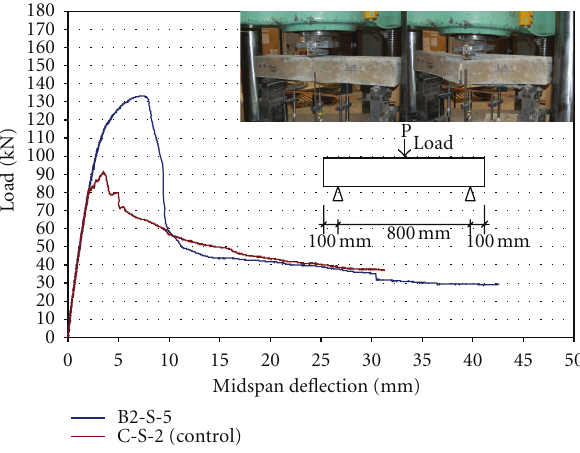
Figure 15 for comparison. Test results of beams B2-S-1, B2- S-2, B2-S-3, B2-S-4, and B2-S-5 (beams with Φ 4.75 stirrups